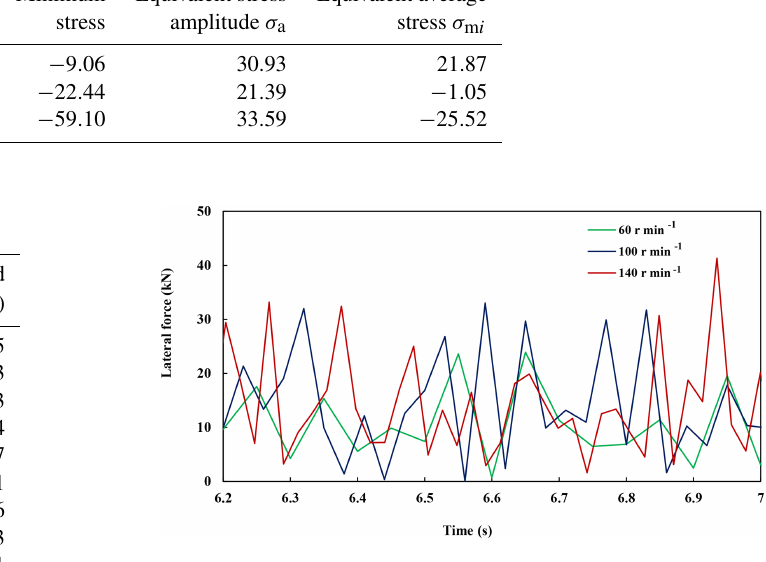
Figure 6. Lateral force time series of each